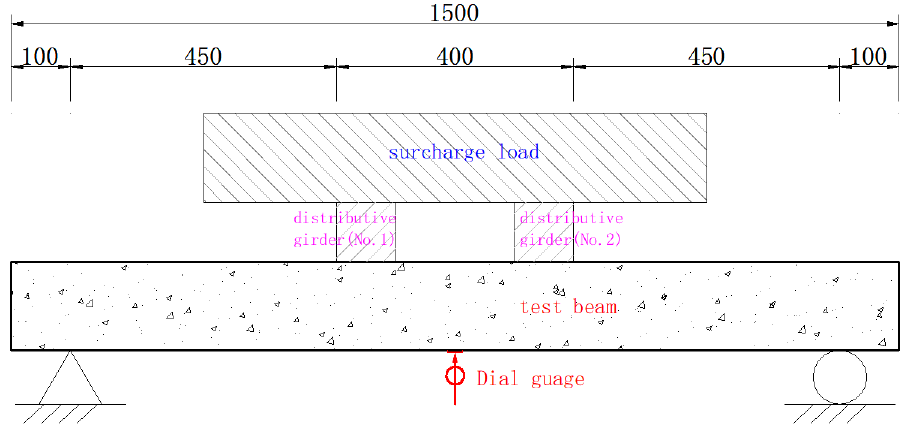
Figure 2. Loading diagram (Unit: mm).